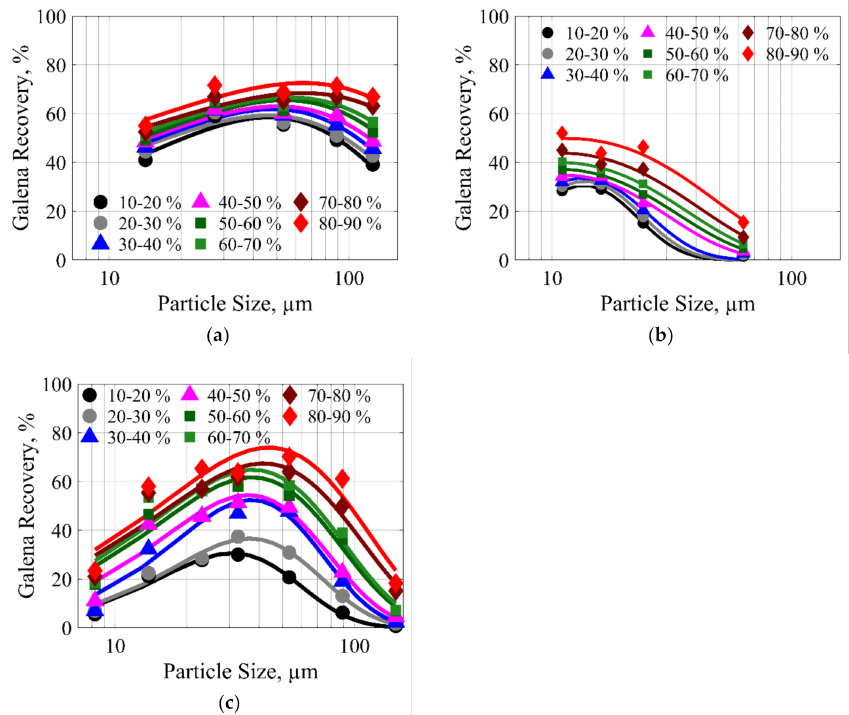
Figure 2. Galena recoveries versus particle size: ( a ) Vianna [8] 15 g/ton of Aerophine 3418A, ( b ) Savassi [13] 10 cells in series, and ( c ) Welsby [9] 15 g/ton of Sodium Ethyl Xanthate. Experimental data are presented as datapoints and model fitting as trend line. X-axes in